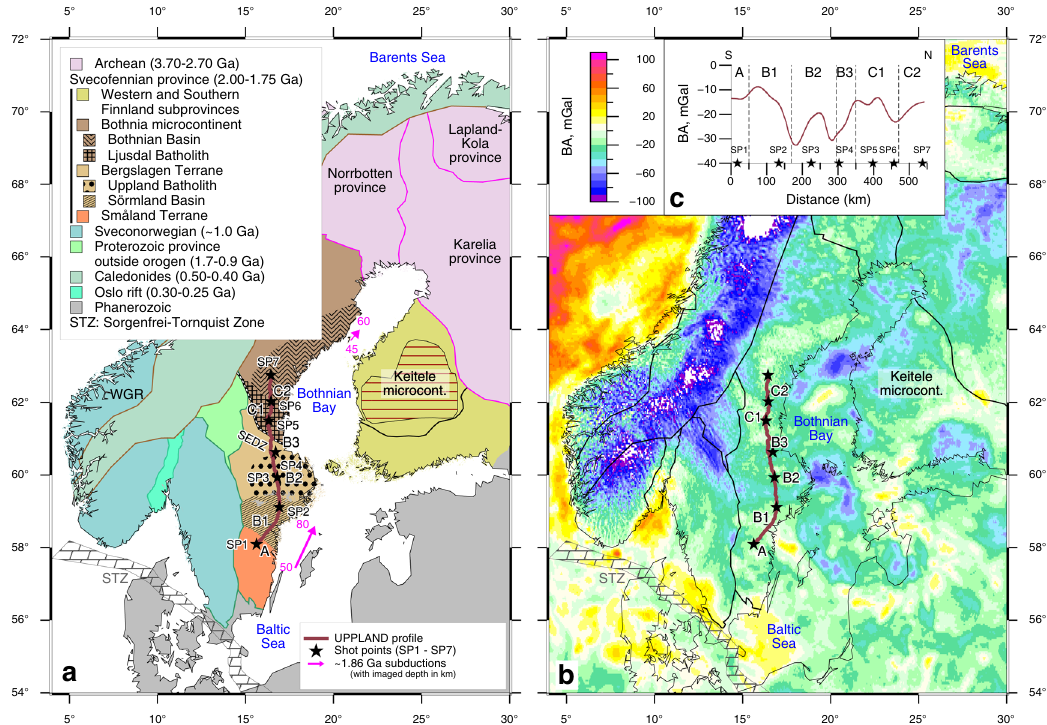
Fig. 1 Tectonic sketch and Bouguer gravity anomaly maps with location of the UPPLAND seimic pro fi le. ( a ) Tectonic sketch map, ( b ) Bouguer gravity anomaly map and ( c ) upward continued gravity data along the seismic pro fi le. Black stars (SP1 – SP7) — seismic source locations. Magenta lines — dip of Proterozoic subductions imaged seismically. Major tectonic units: A — Småland Terrane, B1 — Sörmland Basin, B2 — Uppland Batholith, B3 — major deformation zone, C1 — Ljusdal Batholith, C2 — Bothnian Basin. SEDZ Störsjon – Edsbyn Deformation Zone, WGR Western Gneiss Region, STZ Sorgenfrei – Tornquist